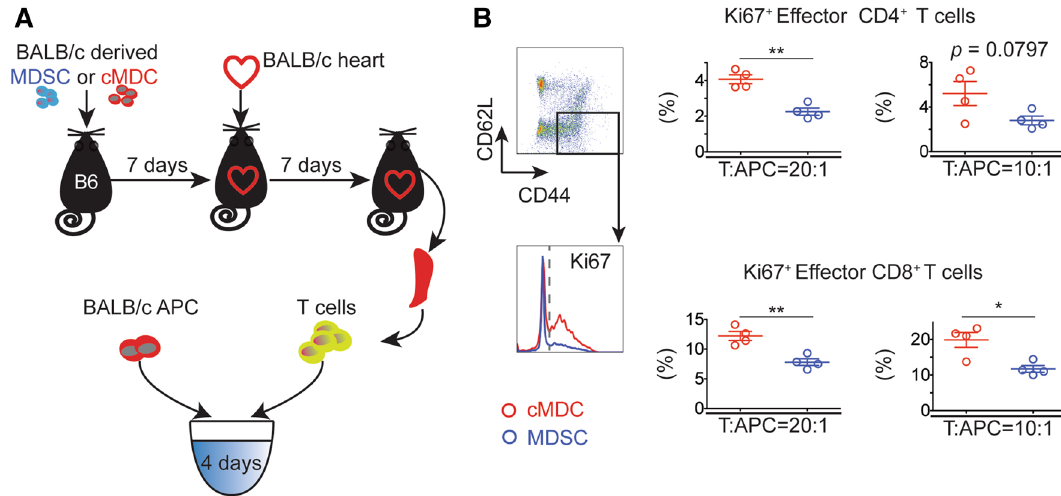
Figure 3. Donor-derived MDSCs suppress effector T cell activation. ( A ) Schematic diagram of the experimental design. T cells were isolated from recipient splenocytes on POD7 and were stimulated with BALB/c cDCs for 4 days (n = 4 per group). ( B ) CD4 + and CD8 + effector T cells induction was analyzed by flow cytometry. Cells were gated on CD4 + Teff (CD4 + FoxP3 - CD44 + CD62 lo ) and CD8 + Teff (CD8 + FoxP3 - CD44 + CD62 lo ). Graphs showing the percentage of activated Teff (Ki67 + Teff). Mean ± SEM, *p < 0.05, **p < 0.01, two-tailed unpaired t test. Data represents one of 4 separate